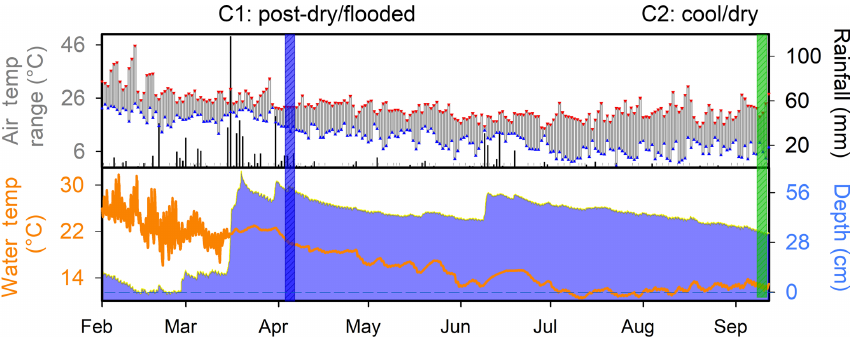
Figure 2. Hydrograph for 7 months in 2017 indicating daily rainfall, maximum–minimum air temperature, water temperature, and antecedent hydrology. Vertical coloured bands represent the two fieldwork campaigns. Table 1. Summary of plant-mediated CH 4 fluxes from the seasonal wetland time series and diel CH 4 diffusive fluxes and ebullition from the permanent wetland during C1 (post-dry–flooded) and C2 (cool–drying). The corresponding sediment core data are average concentrations from 0 to 20cm below ground